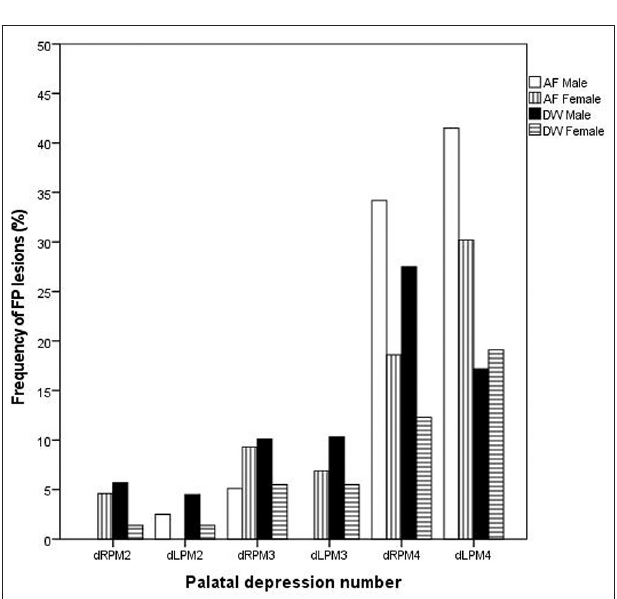
FIGURE 2 | Bar chart depicting the frequency (%) of palatal depressions inflamed at the initial evaluations between the two facilities (AF, AfriCat; DW, The Ann van Dyk Cheetah